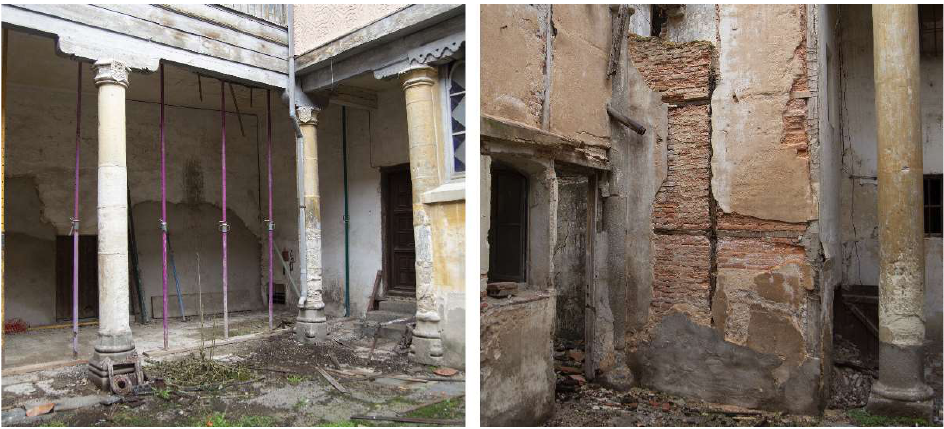
Figure 5. Details of the internal cloister.